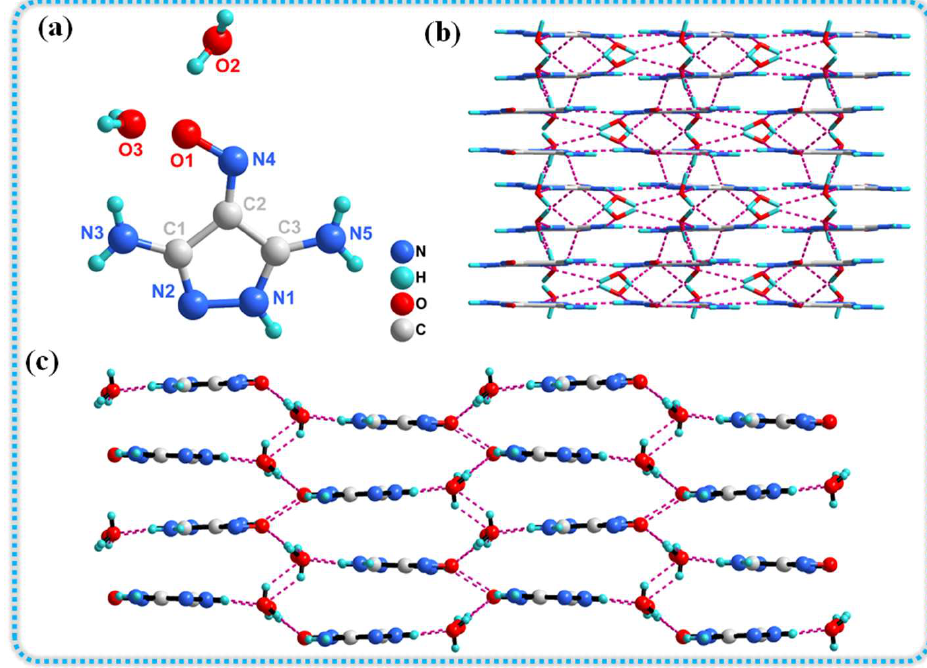
Figure 1. ( a ) Molecular structure of DAPO·2H 2 O; ( b ) Crystal stacking of DAPO·2H 2 O; ( c ) 1D chain structure and hydrogen bonding network of DAPO·2H 2 O.